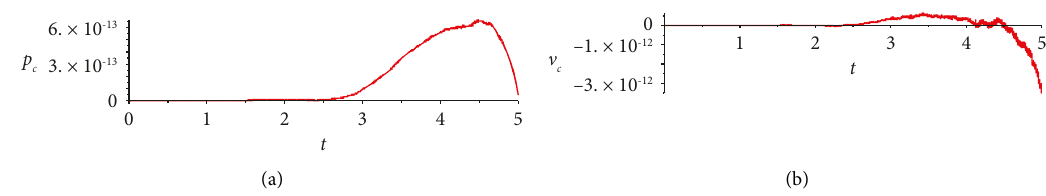
Figure 12: The error in the position constraint g ( u ) � 0 (a) and the error in the velocity constraint g